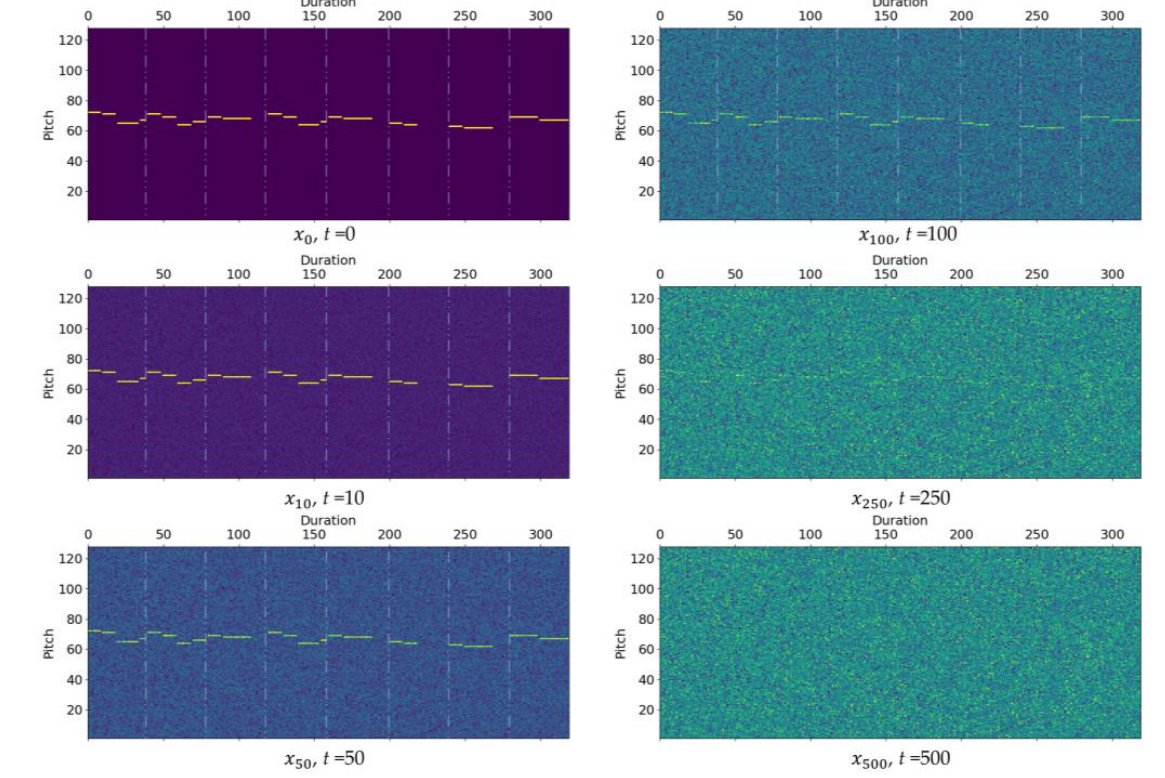
Figure 5. Examples of noise-added melodies at different time steps.